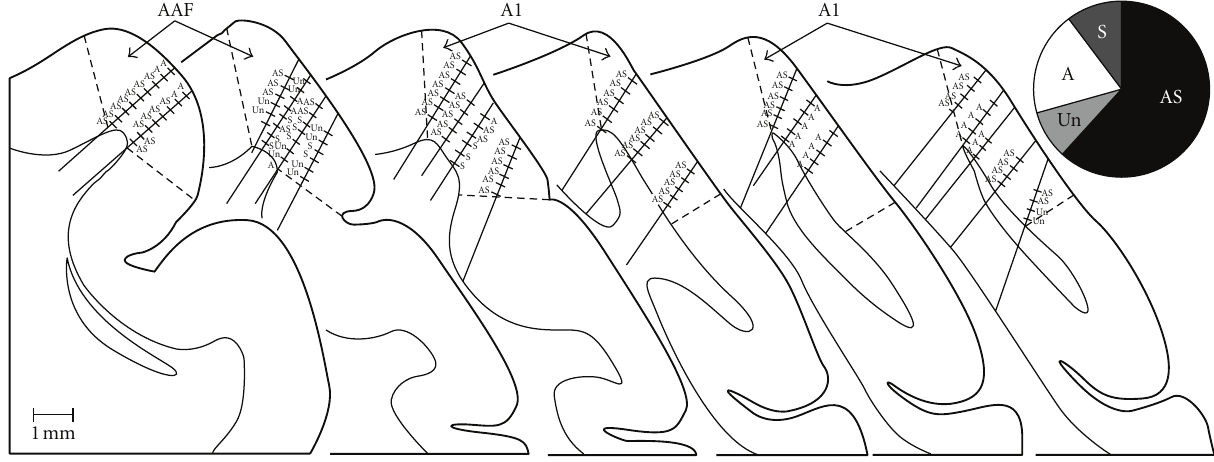
Figure 4: Coronal sections through core auditory cortex (AAF and A1) summarize each of the single-unit recording penetrations ( n = 21) in ferrets with early hearing loss. For each penetration, the hashmarks indicate the location of an identified neuron ( n = 132) whose functional properties are indicated: A = auditory; S = somatosensory; AS = auditory-somatosensory; Un = unresponsive. The pie chart (top right) summarizes the proportions of encountered neuron types: AS = 62%; S = 10%; A = 19%; and Un = 9%. The coronal sections are serially arranged (anterior : left) with the thin contour representing the gray-white border and the dashed lines indicating the presumed borders of AAF and A1. Because the sulcal borders of these regions have not been mapped, it was assumed that the sulcal extent of each area terminated at the lip of the sulcus. Only those neurons whose location plotted within the depicted borders of AAF/A1 were included in this study. Not all neurons are plotted due to